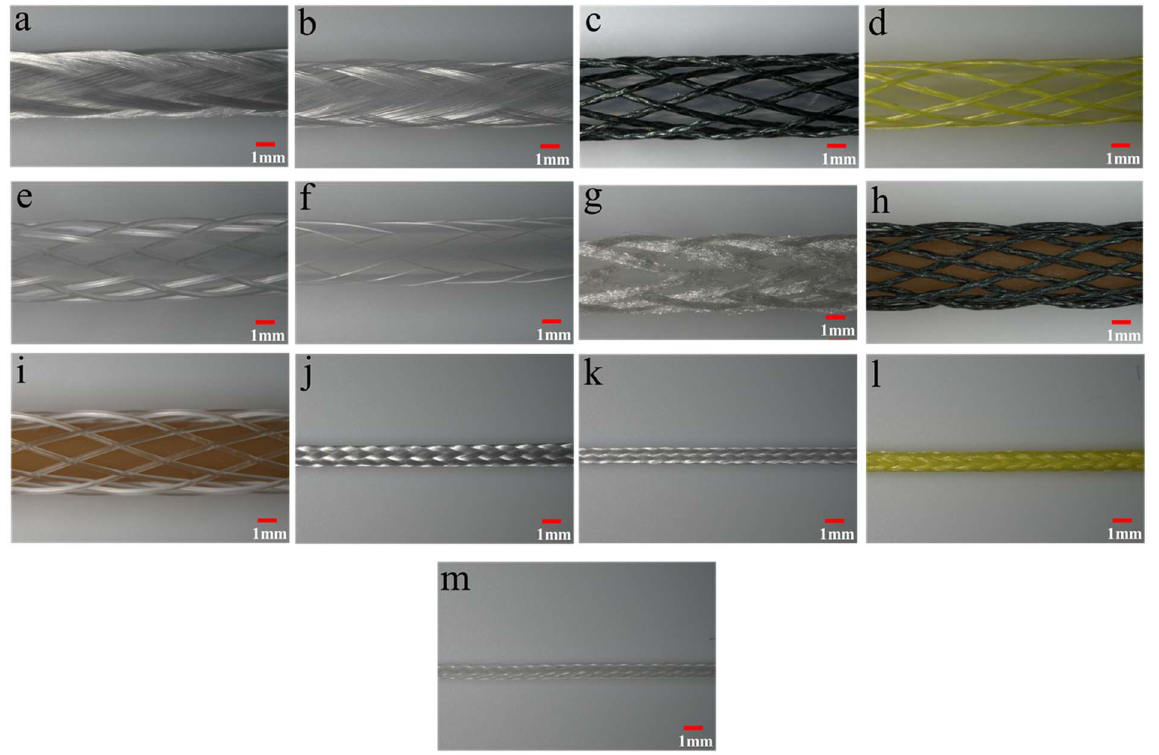
Figure 4. Optical microscopic images of PAM samples. ( a ) PAM 1-1; ( b) PAM 1-2; ( c ) PAM 1-3; ( d ) PAM 1-4; ( e ) PAM 1-5; ( f ) PAM 1-6; ( g ) PAM 1-7; ( h ) PAM 2-3; ( i ) PAM 2-5; ( j ) PAM 3-1; ( k ) PAM 3-2; ( l ) PAM 3-4; ( m ) PAM 3-6.